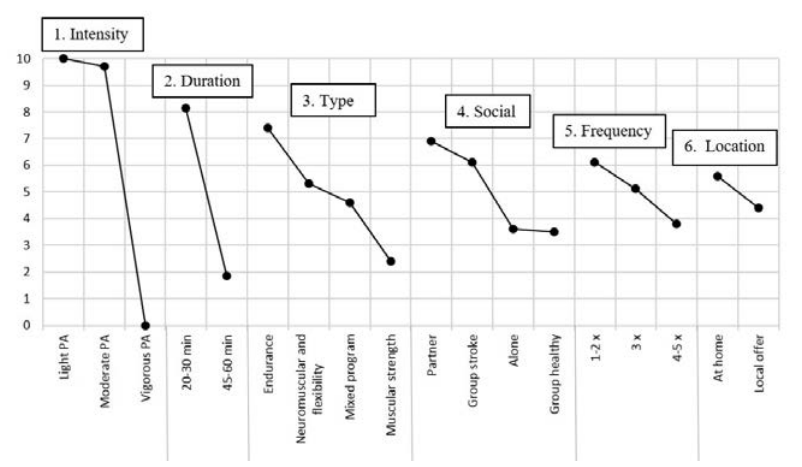
Figure 2. Relative importance of the exercise attributes and their associated levels. Duration is per training sessions. Frequency is per week. Abbreviations: DCE, discrete choice experiment; Min, Minutes; PA, physical